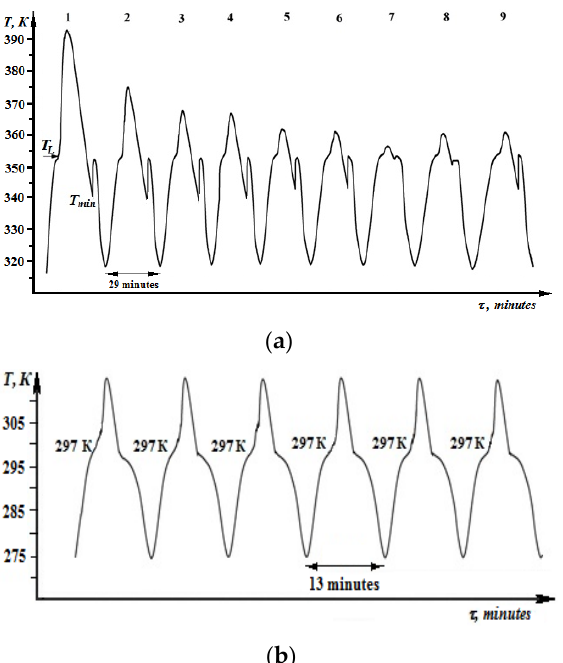
Figure 2. Cyclic thermograms characterizing the influence of melt overheating on supercooling ( a ) for the example of naphthalene and the reproducibility of thermal effects ( b ) for eutectic alloys with 50 masses. % O-terphenyl—50 mass. % dibenzyl—50